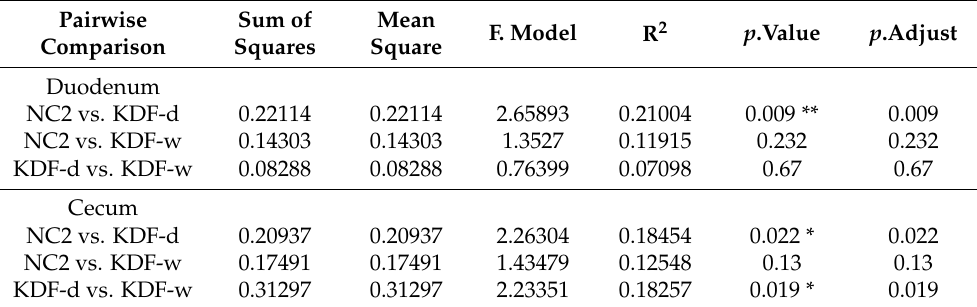
NC2: chickens supplied with non-supplemented diet and water without infection (n = 6); KDF-d: chickens supplied with 0.5% KDF in diet without infection (n = 6); KDF-w: chickens supplied with 0.1% KDF in drinking water without infection (n = 6). Data of each group were obtained from chickens at 21 days of age (n = 6). * p < 0.05, ** p < 0.01.